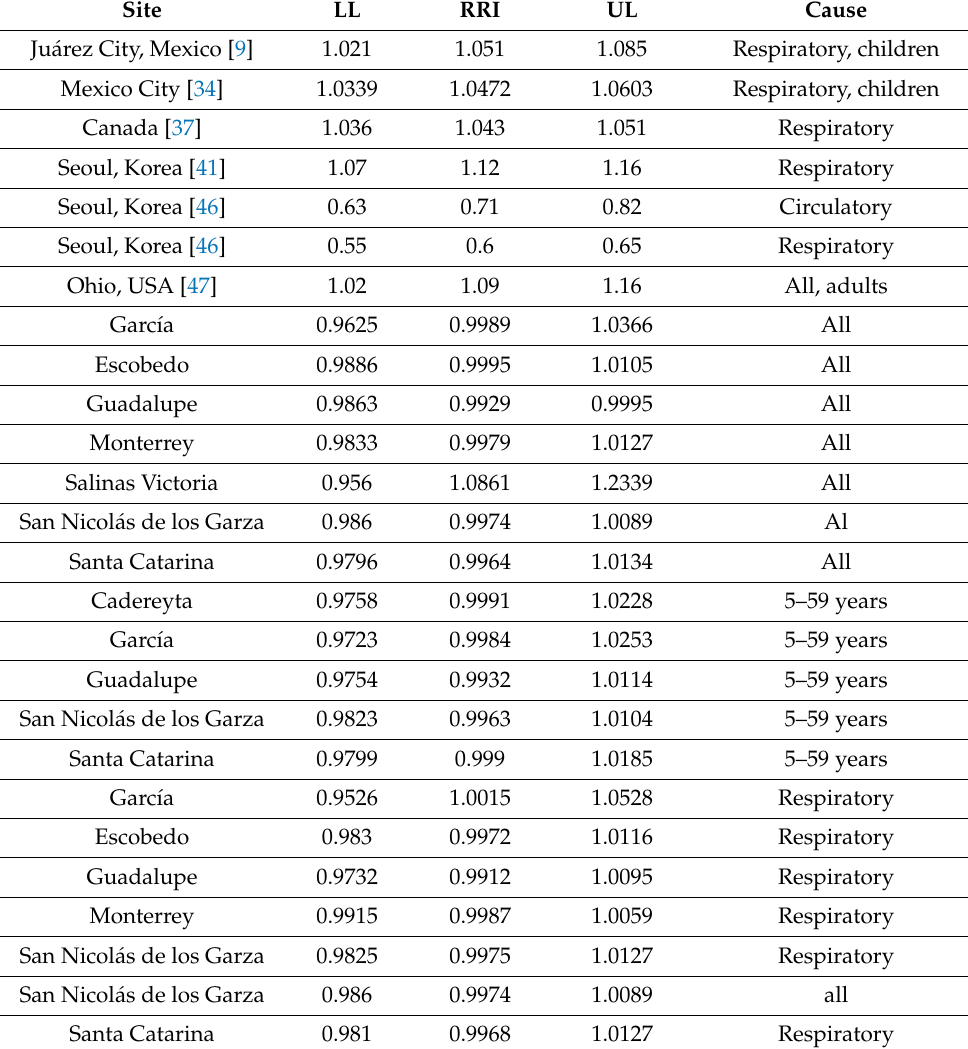
Table 6. RRI, lower and upper limit values found in MAM for O 3 during the study period, and comparison with values reported by other studies around the